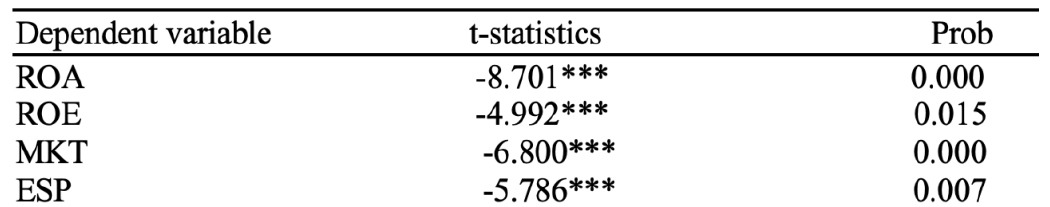
Table 3: Kao Residual Panel Co-integration